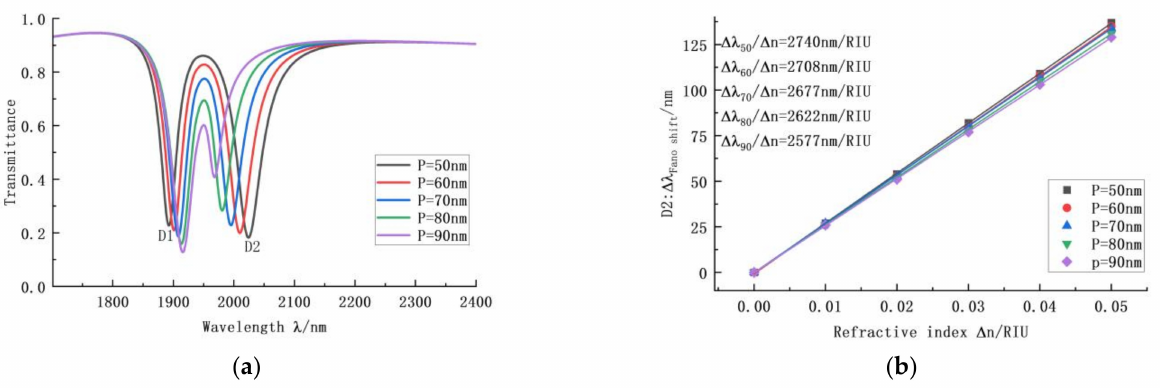
Figure 4. ( a ) Transmission curve spectrum when P is changed. ( b ) Sensitivity of the fit to the D2 trough as P